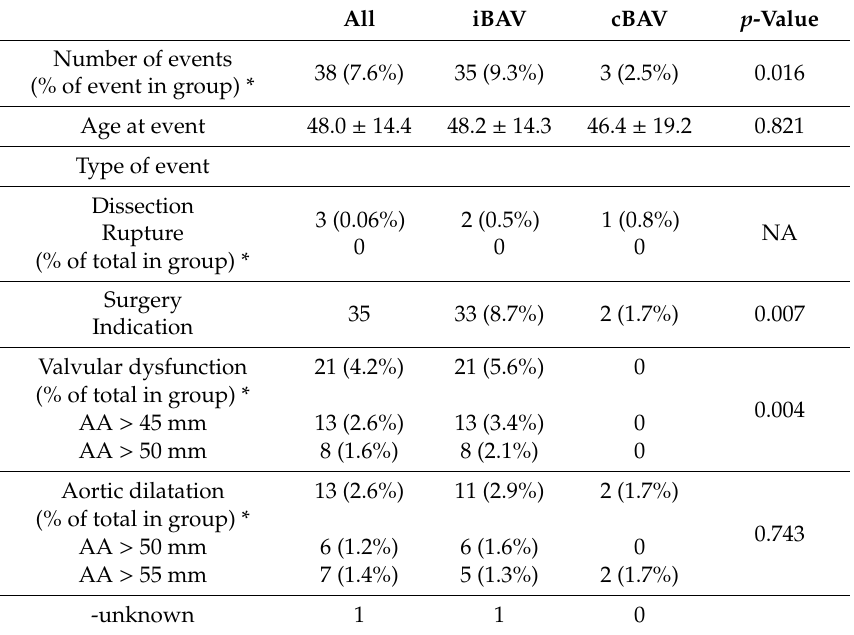
Table 2. Characteristics of BAV patients with an aortic event.